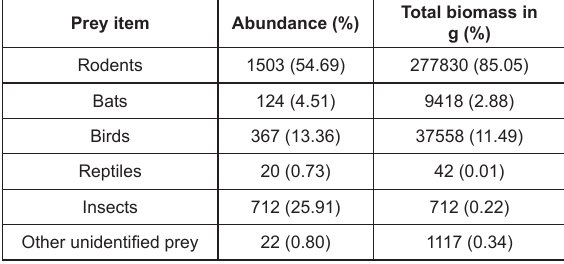
Table 1. Abundance and total biomass of different prey in the diet of the Indian Eagle Owl in the study area. Prey item Abundance